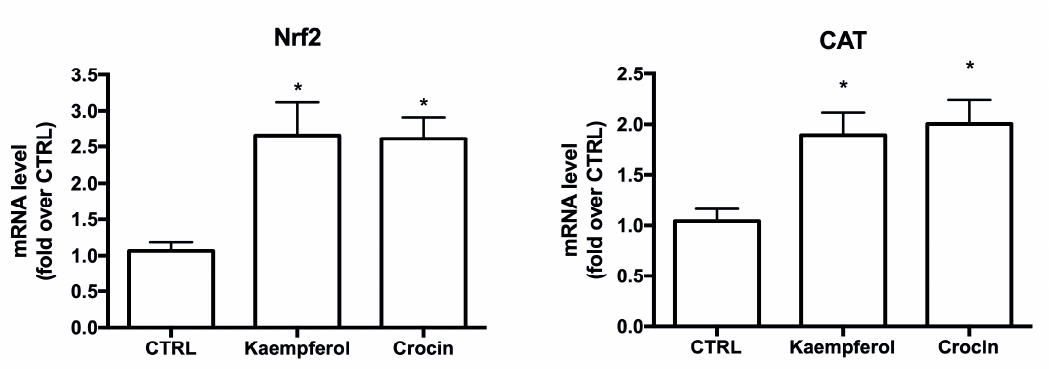
Figure 9. Effect of kaempferol and crocin on Nrf2 and antioxidant enzyme catalase (CAT) expression. Real time-PCR was performed to detect Nrf2 and CAT mRNA levels. Data are expressed as relative abundance compared to untreated cells. Each bar represents mean ± SEM of three independent experiments. Data were analyzed with one-way ANOVA followed by the Bonferroni’s test. * p < 0.05 vs. CTRL.